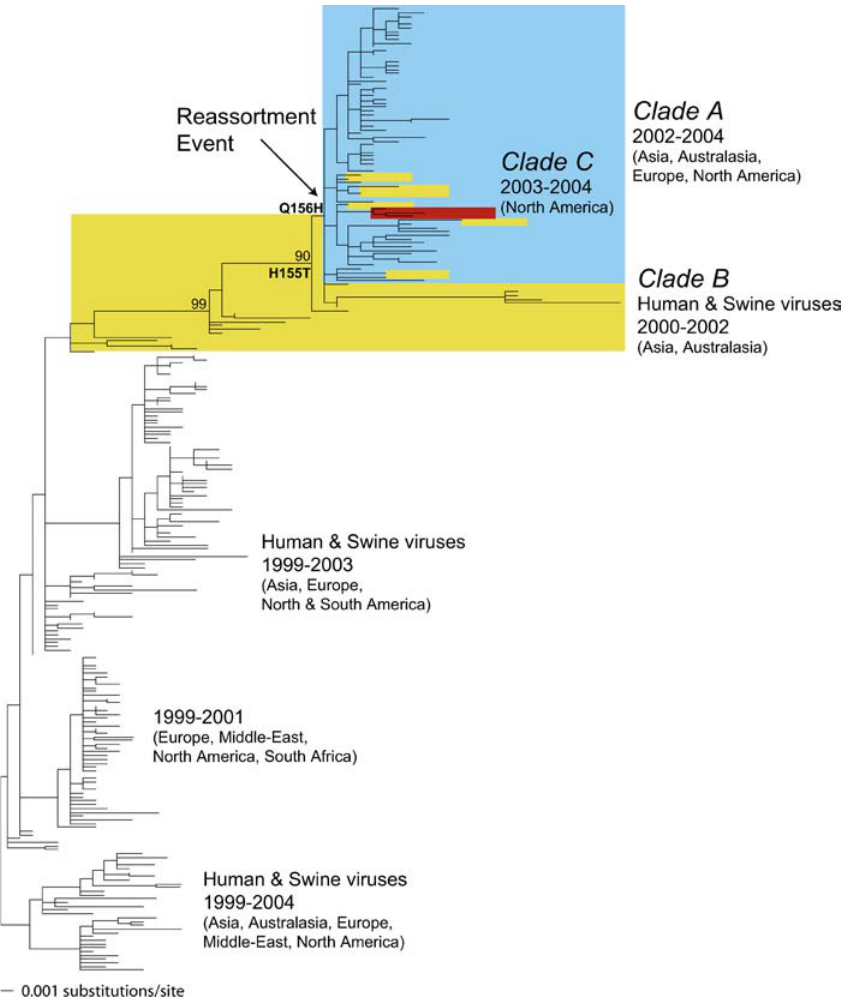
Figure 4. Evolutionary Relationships of 256 Sequences of the HA1 Sequences Sampled from Mammalian Hosts during 1999–2004 The maximum likelihood phylogenetic tree is rooted on a divergent set of human and swine viruses for purposes of clarity only, and all horizontal branch lengths are drawn to scale. Bootstrap values are shown for key nodes. Colors are as in Figure 1, with yellow indicating all those viruses identified as clade B viruses from the analysis of the expanded NA dataset. The phylogenetic location of the reassortment event between clades A and B was set at the position of the most basal clade A virus, defined on the basis of the NA analysis, within the older clade B. The phylogenetic locations of the two critical antigenic mutations at sites 155 and 156 are also shown. DOI: 10.1371/journal.pbio.0030300.g004